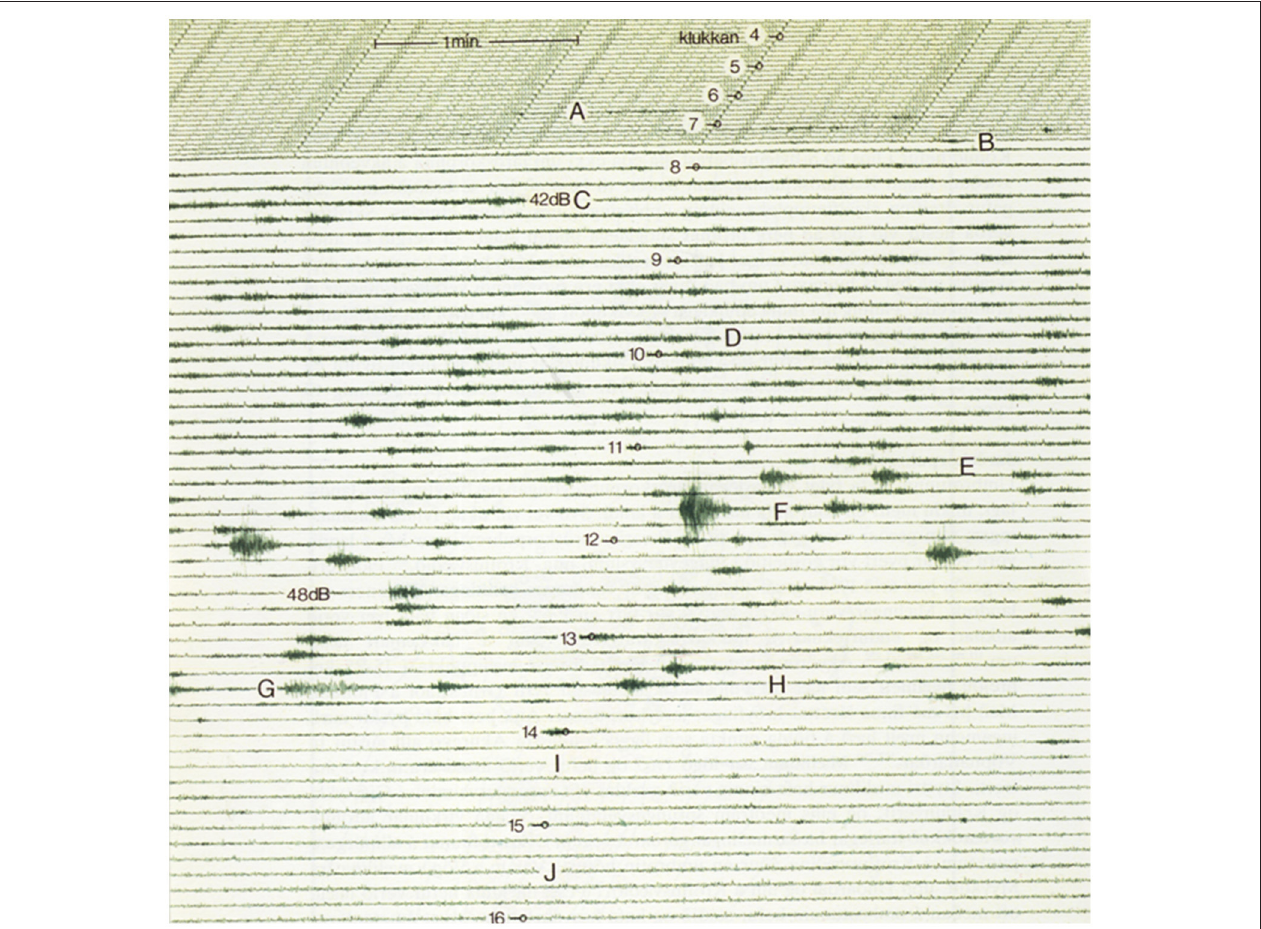
FIGURE 3 | Seismic precursory activity to the Krafla eruption on January 30, 1981, as seen on the seismogram from Reynihlíð, about 10km SSW of the caldera center. Only 40% of the seismogram is shown. Numbers show the hour-marks. A marks a passing car, B beginning of the spasmodic tremor, D typical spasmodic tremor, E and F increasing high-frequency earthquake activity, G low-frequency earthquake, H earthquake activity decreases, eruption begins at 14:10, I and J mark low-frequency tremor. From Einarsson (1991b). Reproduced with the permission of the copyright holder, the Icelandic Natural History